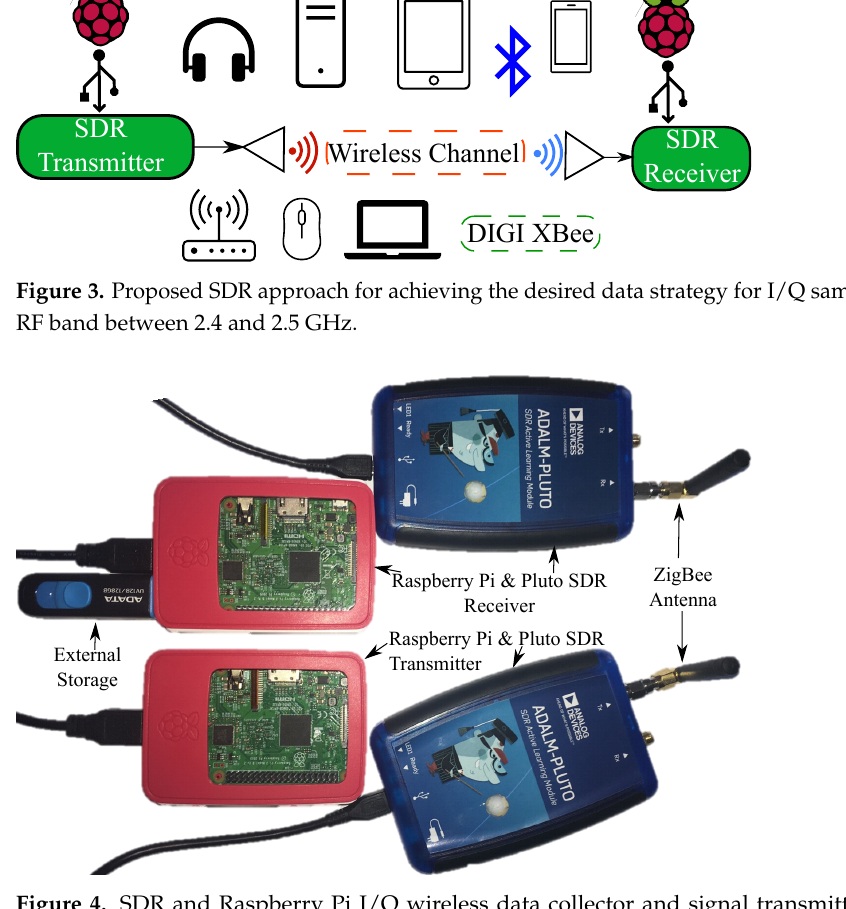
Figure 4. SDR and Raspberry Pi I/Q wireless data collector and signal transmitter for wireless transmissions in the 2.4–2.5 GHz ISM RF